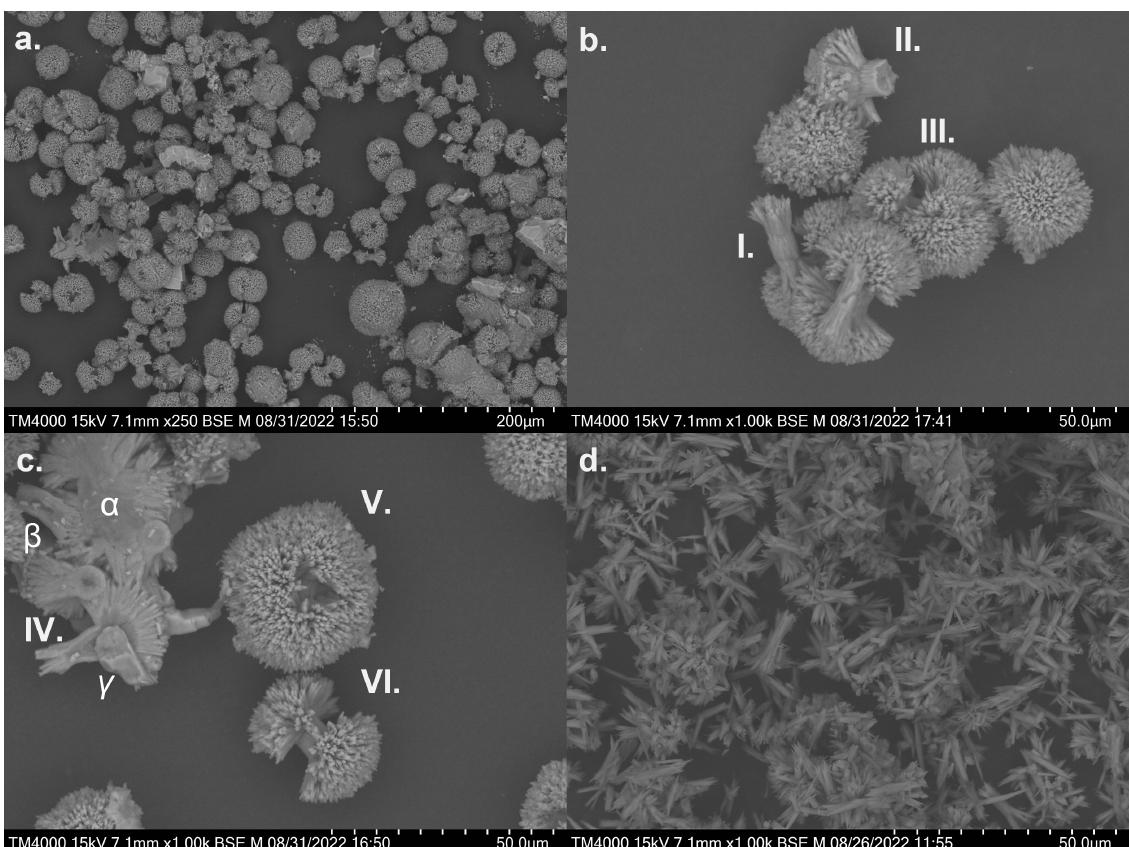
Figure 9. Selection of scanning electron microscope images of filtered precipitates from experiments IIa (non-CO 2 -equilibrated – after 4d) and V (Ca(OH) 2 ): (a) overview of IIa; (b) cluster of precipitates; (c) detailed shot of precipitates and cross section through a cluster, showing the internal crystal growth structures (d) overview of precipitates from experiment V (Ca(OH) 2 – after